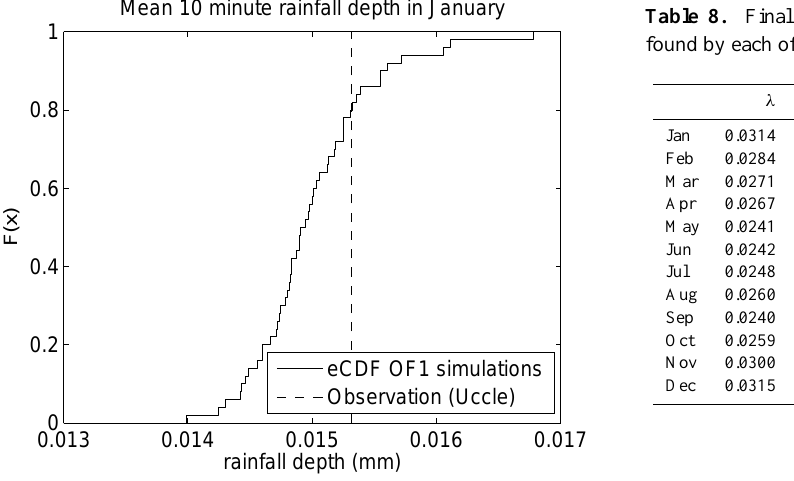
Table 9. Model performance measures for the MBL model fitted with different objective